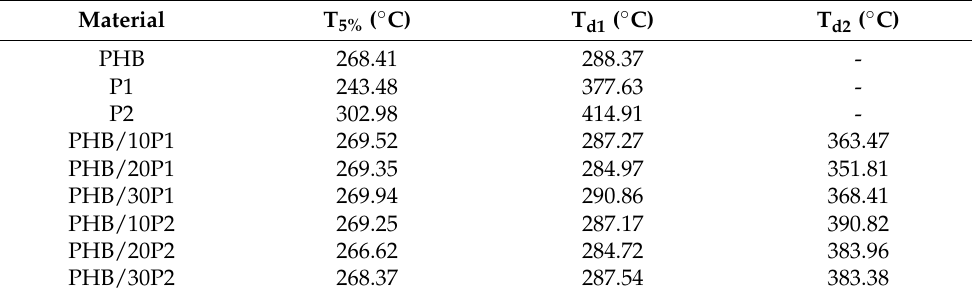
Figure 4. TGA ( a , c ) and DTG ( b , d ) curves of PHB, PHB/P1, and PHB/P2. Table 2. Thermal degradation parameters of PHB, PHB/P1, and PHB/P2 blends.